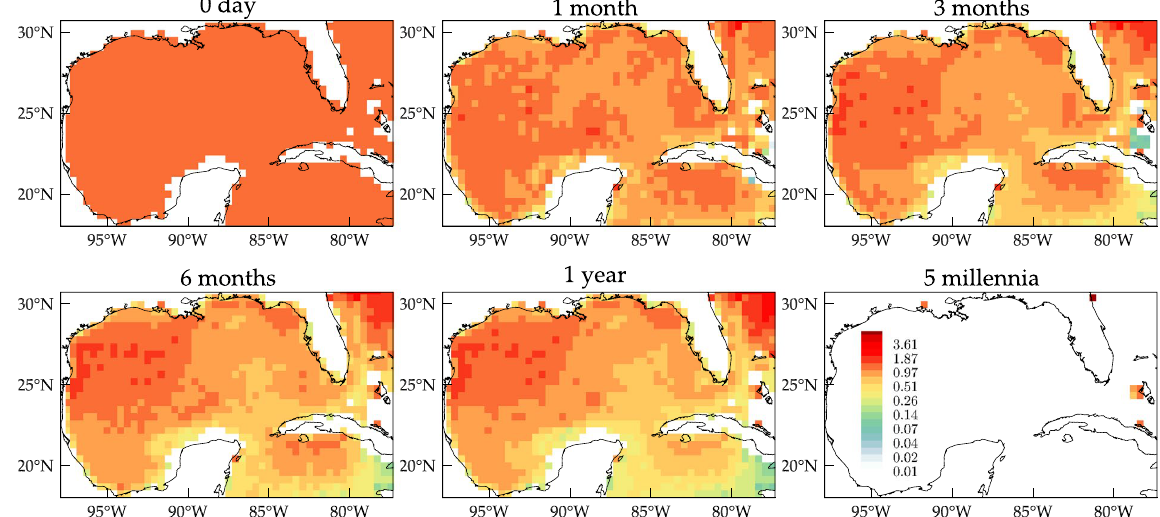
Figure 3. Forward evolution of an initially uniformly distributed tracer under the action of the transition matrix P . The tracer concentration is normalized by the mean concentration and subjected to a fourth-root transformation. Computations carried using Matlab R2017a (http://www.mathworks.com/) and visualization using Tecplot 360 2016 R2